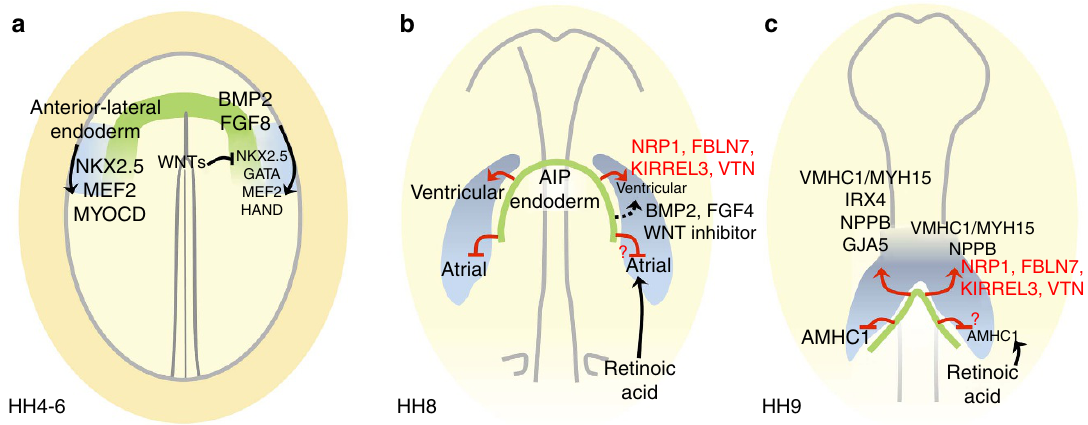
Figure 5 | Successive roles of the endoderm in heart induction and patterning. Each diagram represents a stage in development; in each, tissue interactions are depicted on the left, signals on the right. ( a ) Initially (HH 4–6), the anterior-lateral endoderm (including some prospective AIP 56 , green) is required for the adjacent cardiac mesoderm (light blue) to express NKX2.5 , MEF2C 29 and MYOCD 43 . BMP2 and FGF8 signalling from the anterior-lateral endoderm induce NKX2.5 , GATA , MEF2 and HAND transcription factors 22,34,51,52 . The anterior endoderm expresses WNT inhibitors including Crescent, which can induce NKX2.5 (ref. 49). ( b ) At HH8, progenitor cells are becoming determined as either atrial or ventricular 28,57,58 . The AIP endoderm induces ventricular character and represses atrial identity. Signals from the AIP endoderm, including NRP1, FBLN7, KIRREL3 and VTN described here (red text and arrows) and previously reported BMP2, FGF4 and Wnt inhibitors 22,32,49 (black text and arrows), induce some ventricular markers, which are integrated with atrial-inducing retinoic acid signalling from the posterior lateral plate mesoderm 28,57,59 . The signals from the AIP endoderm that repress atrial identity are unknown. ( c ) At HH9, when regional markers of anterior–posterior heart tube patterning begin to be expressed, AIP endoderm induces ventricular markers VMHC1/MYH15 , IRX4 , NPPB and GJA5 (the latter expressed from HH12) and represses the atrial marker AMHC1 . Four secreted molecules from the AIP endoderm, NRP1, FBLN7, KIRREL3 and VTN can induce VMHC1/MYH15 and